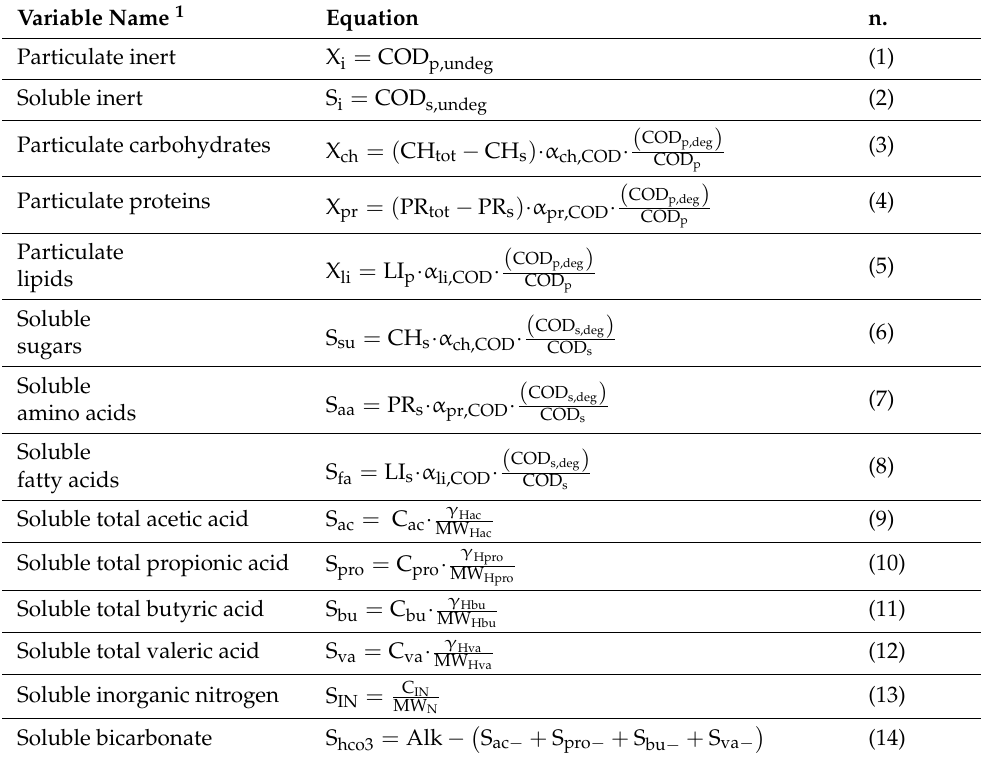
Table A2. Computation of ADM1 state variables from measurements.